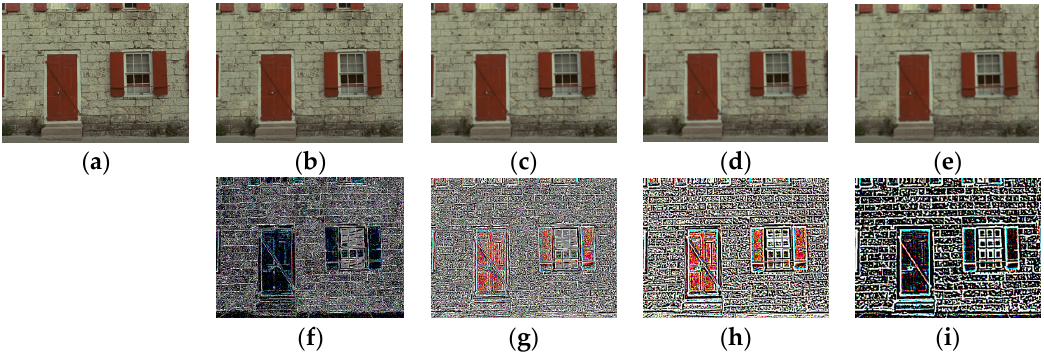
Figure 3. Examples of scale space and contour features of a image in the TID2013 database. ( a )–( e ) are an image scale space of ( a ). ( f )–( i ) are contour features of different scales of ( a ).